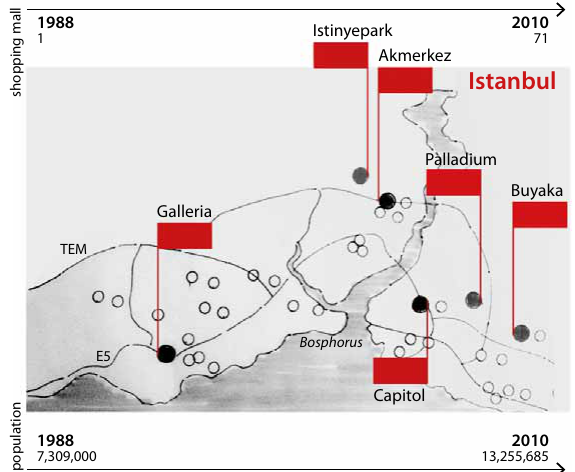
fig. 2. “Istanbul-Shopping Mall” Collage. Source :